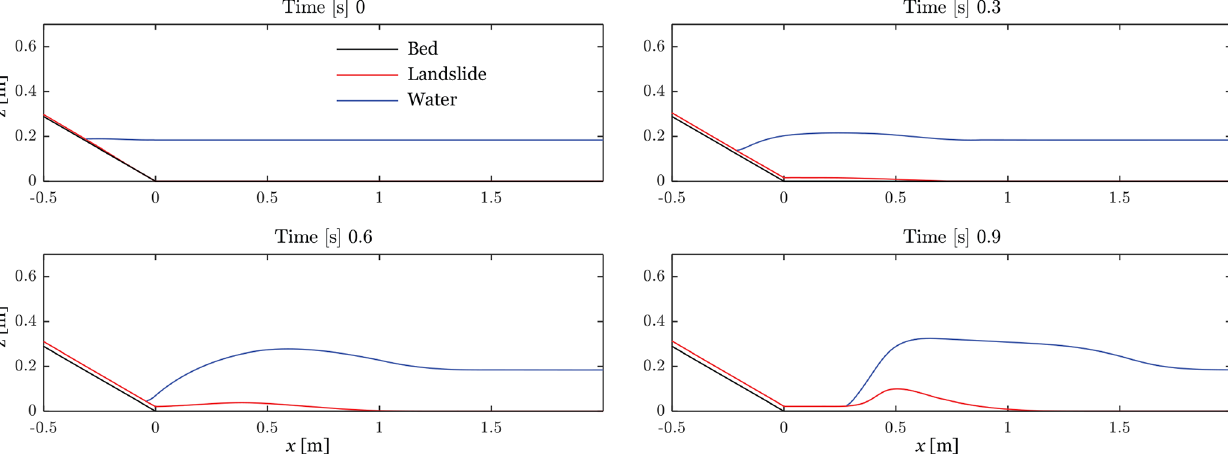
Figure 4. Cross section of the landslide and water surface during numerical simulation of the generation of the